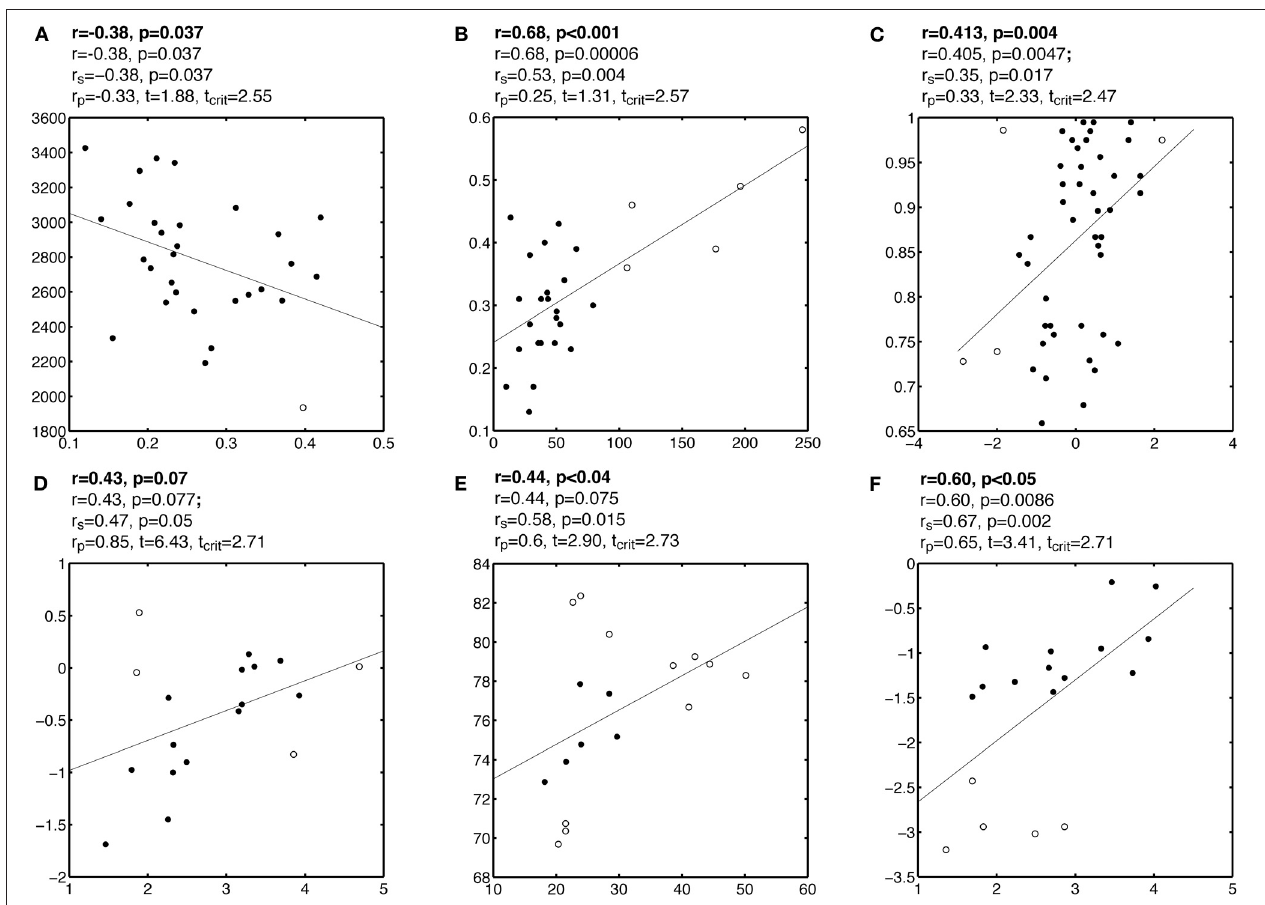
analyses; the third line contains Spearman correlation r s ; the fourth line contains the skipped correlation r p . Subplots A, B, C illustrate correlations that could be due to outliers. Subplot D illustrates a potential case of masking. Subplots E and F show the potentially incorrect use of correlation for what could be split data